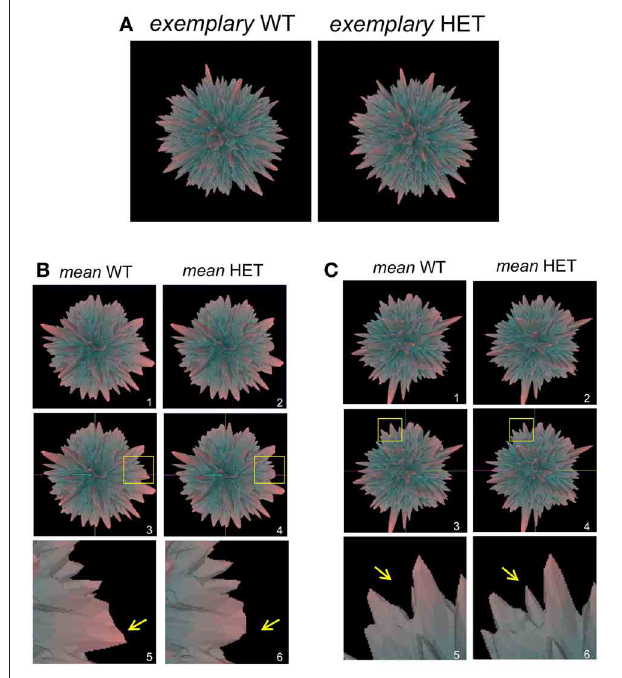
FIGURE 3 | Plurigon -mediated investigation into genotypic data patterns. (A) Exemplary plurigons generated from either a wildtype C576Bl6 mouse (WT) or a GIT2 − / + heterozygous mouse (HET). (B) Mean WT (panel 1) and HET plurigons (panel 2). Panels 3 and 4 indicate the identical coordinate nature of the two mean plurigons in panels 1 and 2. The yellow inset box indicates a region of structural idiosyncrasy between the mean WT and HET plurigons. This yellow inset box is expanded in panels 5 and 6 with associated arrows highlighting the structural variation. (C) Representation of a secondary structural variation in mean WT or HET plurigons. The panel numbering and content is identical to (B)